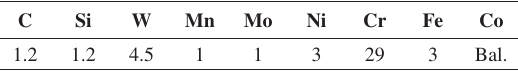
Table 1. Chemical composition of Co-Stellite 6 (wt %).